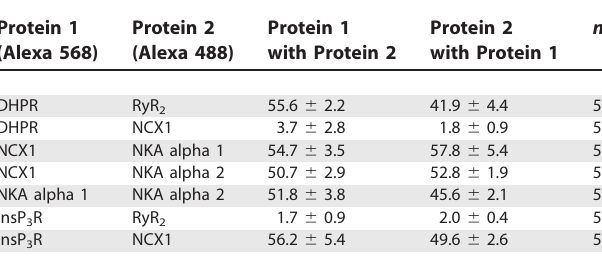
Table 1. Analyses of the Extent of Voxel Co-Localization for Select Cardiac Protein